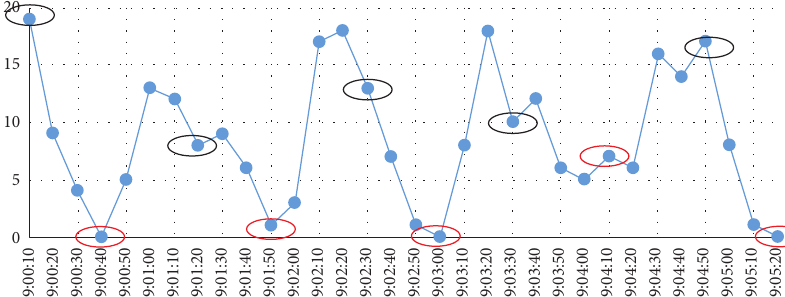
Figure 8: Traffic flow distribution and phase switching